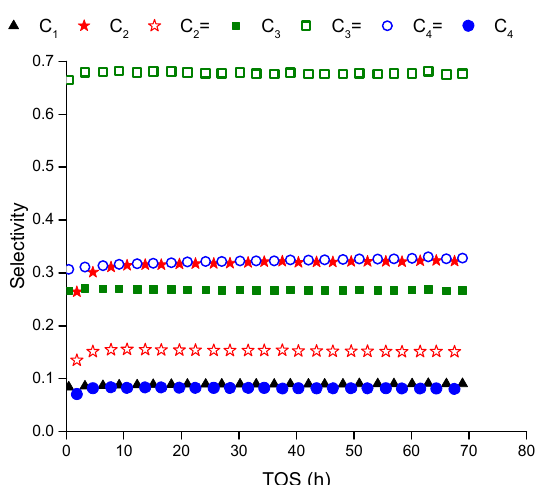
Figure 1. Selectivity of hexane cracking over hydrothermally steamed ZSM-5 at 500 °C and WHSV of 12 h − 1 at the fixed bed reactor. There is a slight dynamic at first 5 h where ethane increases before the plateau.